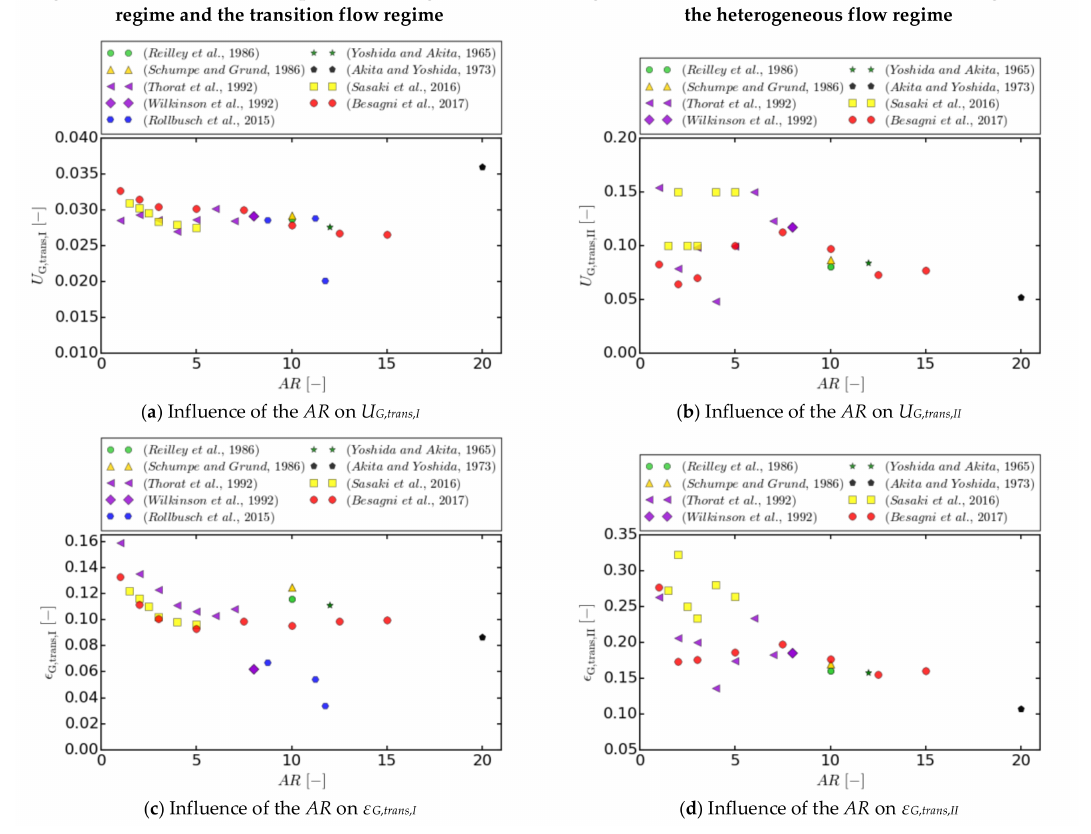
Figure 4. Influence of the aspect ratio ( AR ) on flow regime transition points—data obtained by